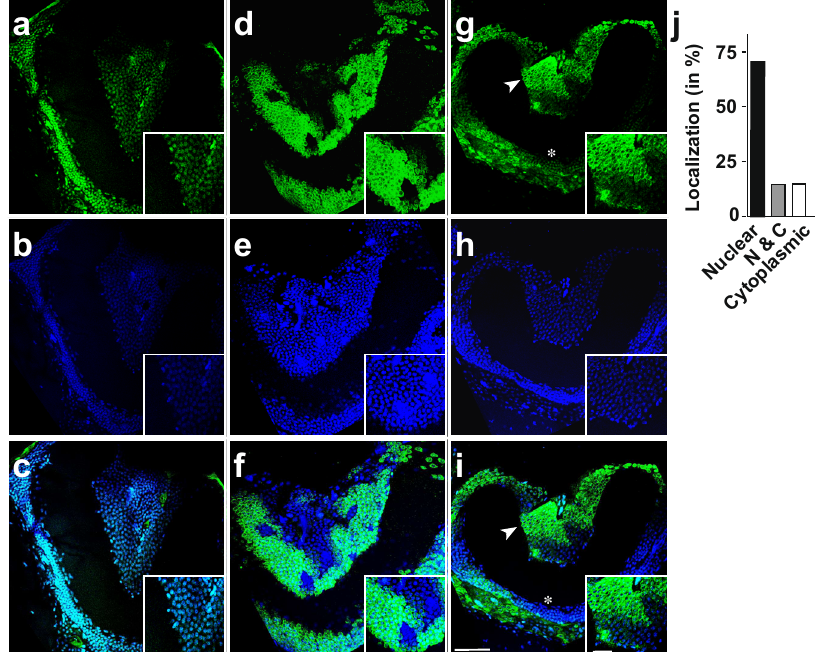
Fig. 5 Localization and expression levels of ELAVL2 are dynamic in mushroom bodies. Representative anti-ELAV antibody stainings in worker bees of mushbodies ( a , d, and g ) counterstained with DAPI to visualize nuclei ( b , e, and h ) and merged pictures ( c , f, and i ). Insets show higher magni fi cations of ubiquitous expression and nuclear localization (inset in a – c ), patchy expression with mostly cytoplasmic localization (inset in d – f ) and patchy expression with nuclear and cytoplasmic expression (inset in g – i , arrowhead in g and i ). The asterisk in g and i indicates nuclear localization in the lower part of the mushroom body. A summary of ELAVL2 localization in mushroom bodies of worker bees is shown in panel j ( n = 20). Scale bars are 30 µ m in i and 6 µ m in the inset. The source data underlying this fi gure are available in Supplementary Data